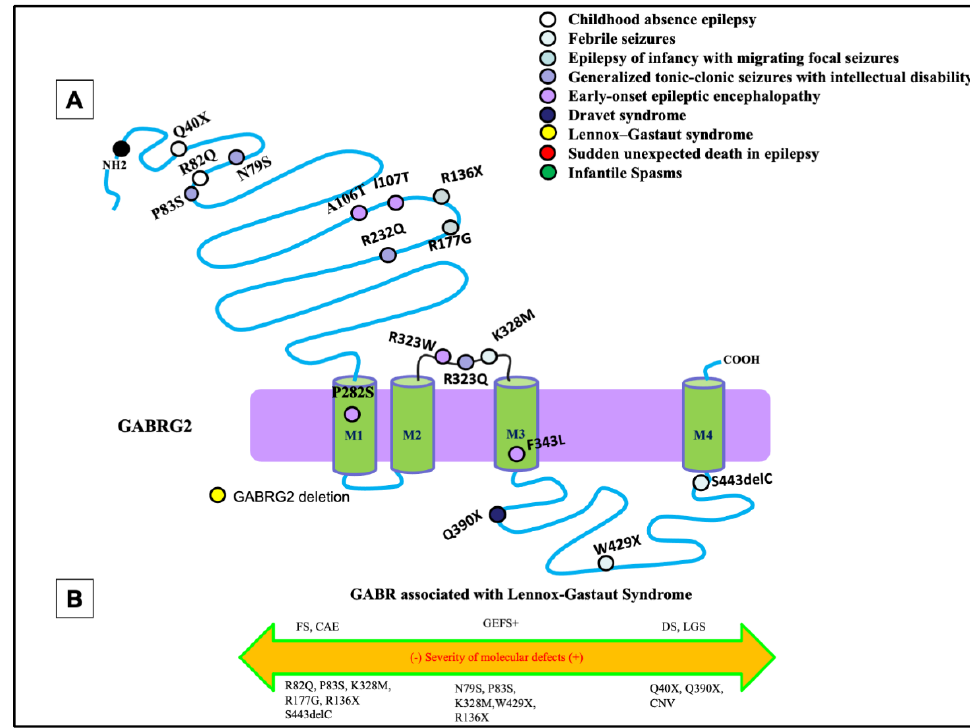
Figure 3. Epilepsy phenotypes associated with GABRG2 mutations. ( A ) Two-dimensional protein topology of the γ 2 subunit showing locations of mutations in human GABRG2 associated with various epilepsy syndromes and neurodevelopmental disorders. Each mutation is color coded to indicate associated diagnosis, and each dot represents the relative location on the γ 2 subunit protein peptide. ( B ) Diagram dictating the severity of each mutation on a continuum of epilepsy phenotypes. The left side of the diagram infers a less severe epileptic phenotype, the middle dictates a moderate, and the right side of the diagram infers a more severe epileptic phenotype.